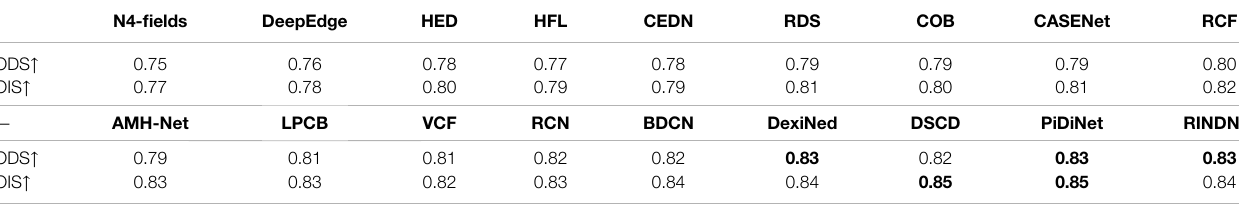
TABLE 3 | Performance comparison of deep learning-based edge detection algorithms on the BSDS500 dataset. N4- fi elds